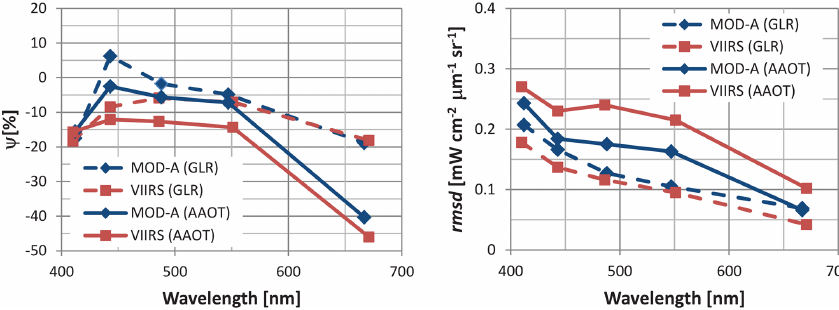
Figure 6. Values of ψ (left panel) and RMSD (right panel) for MODIS-A and VIIRS match-ups for the GLR and AAOT sites.